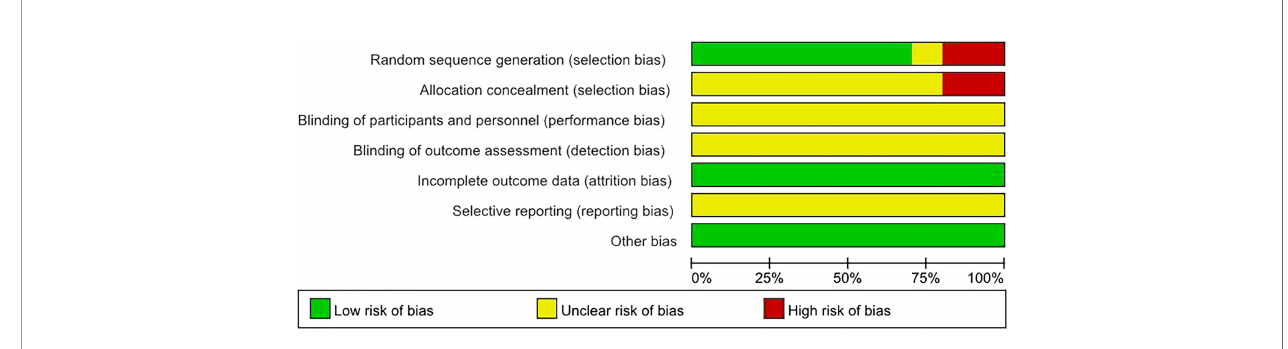
FIGURE 3 | Bias risk assessment chart of